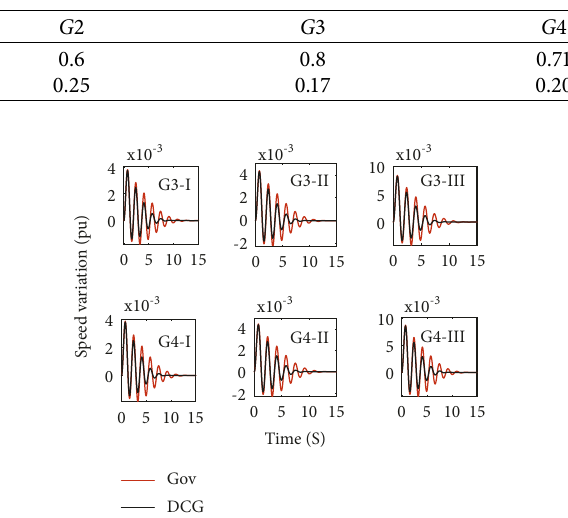
Figure 11: Angular frequency variation for G 1 and G 2 .